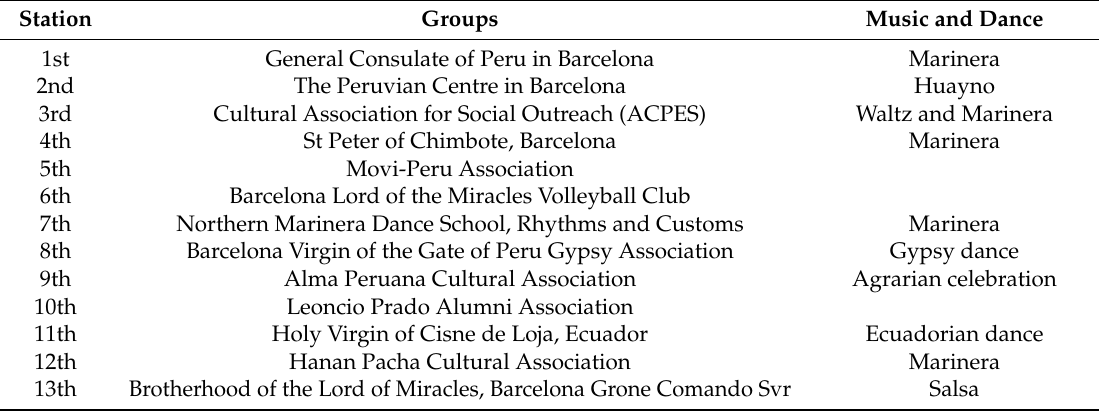
Table 1. Stations, groups, and cultural events in the 2017 procession.